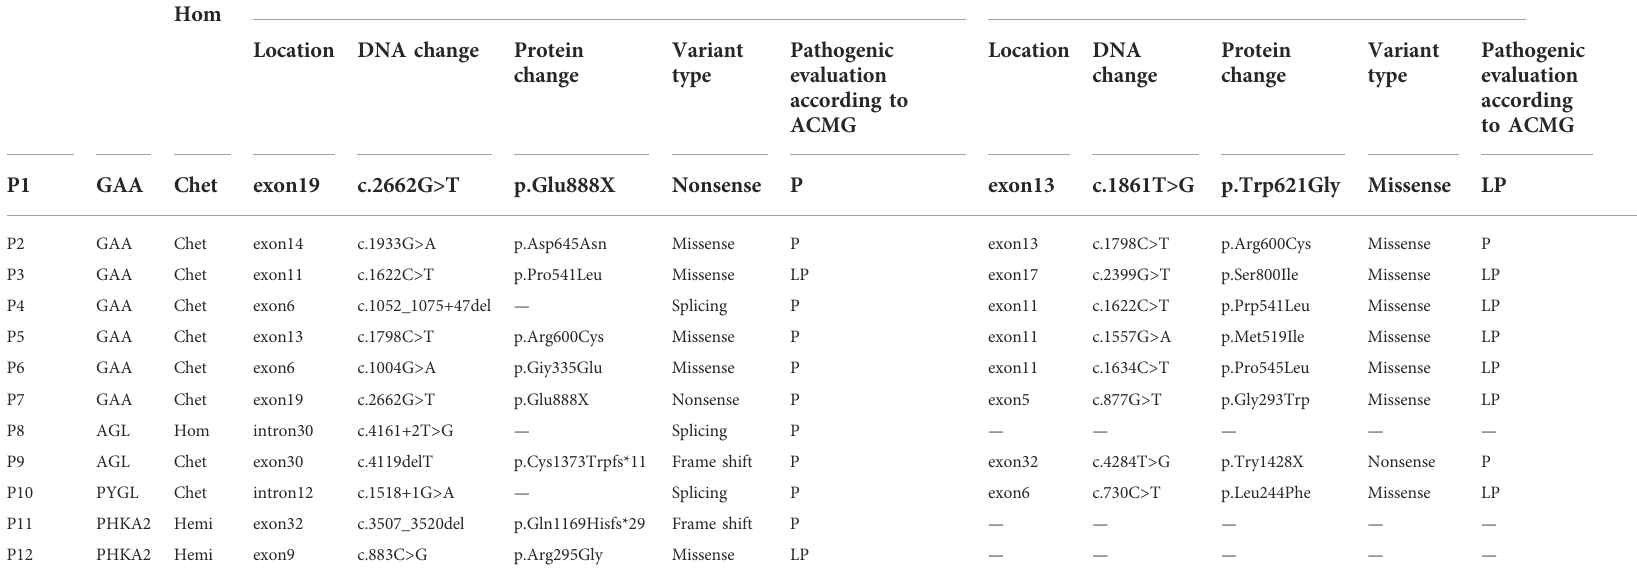
TABLE 2 | Mutations analyzed by WES and classi fi ed according to the ACMG